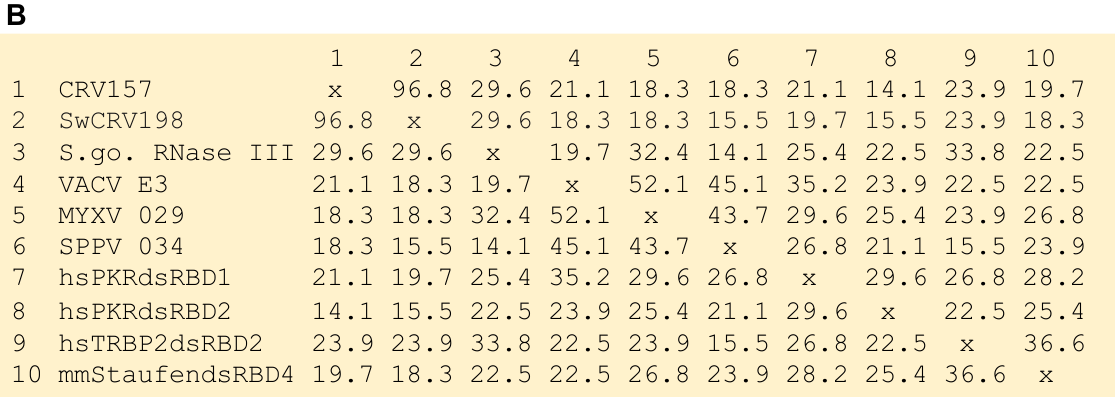
Figure 2. Multiple sequence alignment and sequence identities of CRV157, and selected double- stranded RNA-binding domains. ( A ) multiple sequence alignment of the amino acids from the following double-stranded RNA-binding domain containing proteins was created using MUSCLE: CRV157 (YP_784347.1); saltwater crocodilepox virus (SwCRV) ORF198 (QGT47498.1); Streptomyces gossypiisoli (S. go.) ribonuclease III (WP_232108110.1); vaccinia virus (VACV) E3 (AAA48040.1); myxoma virus (MYXV) 029 (NP_051743.1); sheeppox virus (SSPV) 034 (YP_001293225.1); homo sapiens (hs) PKR; hsTRBP (NP_599150.1; 5N8L_A (PMID: 29449323)); mus musculus (mm) Staufen homolog 2 (EDL14343.1). Secondary structures, as reported for mm Straufen (1UHZ_A), are indi- cated above the alignment. Sequences identical to CRV157 are shown in red. Sequences that were previously shown to be conserved in other dsRBDs in region 2 [55] are shown in blue. Two con- served lysins (K) in CRV157, which were replaced by alanine residues in this study, are shown in bold. ( B ) Percent identities between indicated dsRBDs from the above multiple sequence alignment were calculated in MegAlign.